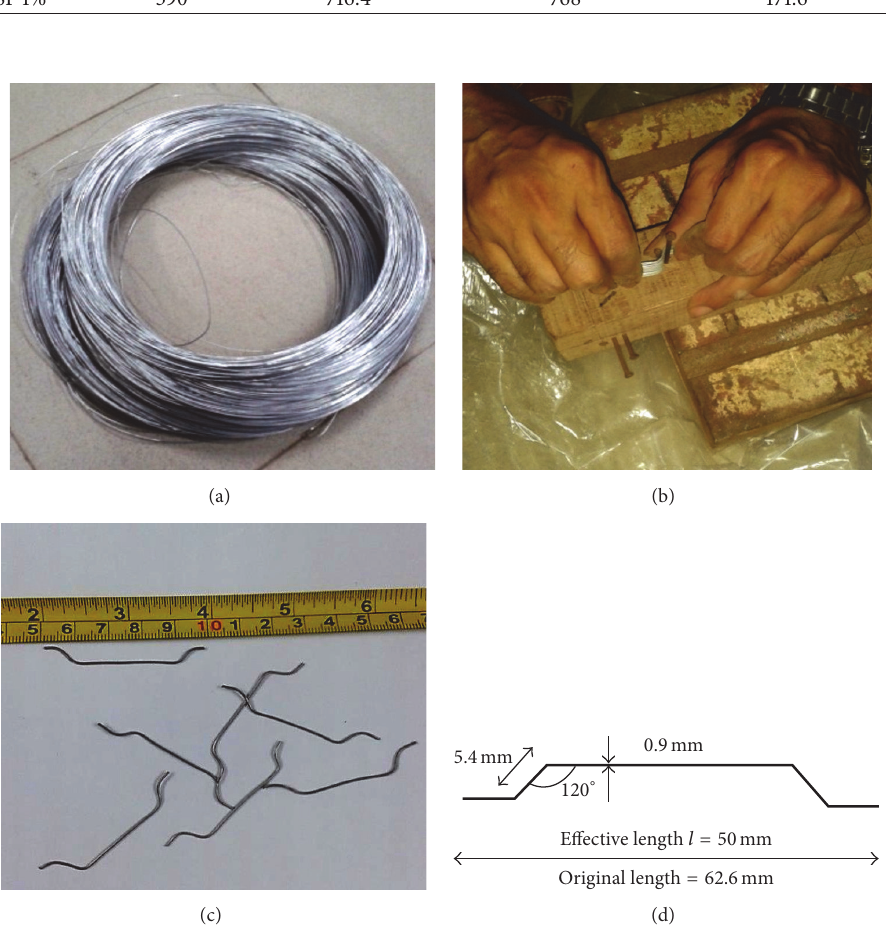
Figure 2: (a) Rolled steel fiber, (b) bending of fiber, (c) prepared steel fiber, and (d) size & geometry of